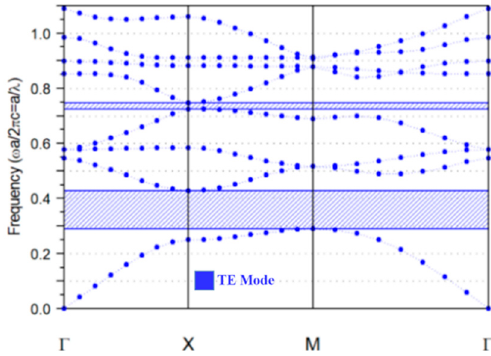
Figure 1. The band diagram of the proposed structure.